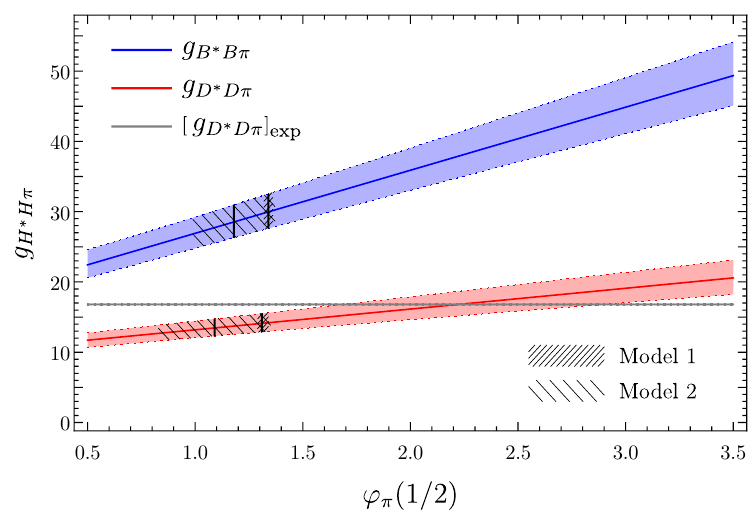
Figure 3 . The dependence of g D ∗ Dπ and g B ∗ Bπ on the value of ϕ π (1 / 2) . The lattice QCD results for the decay constants of heavy mesons are